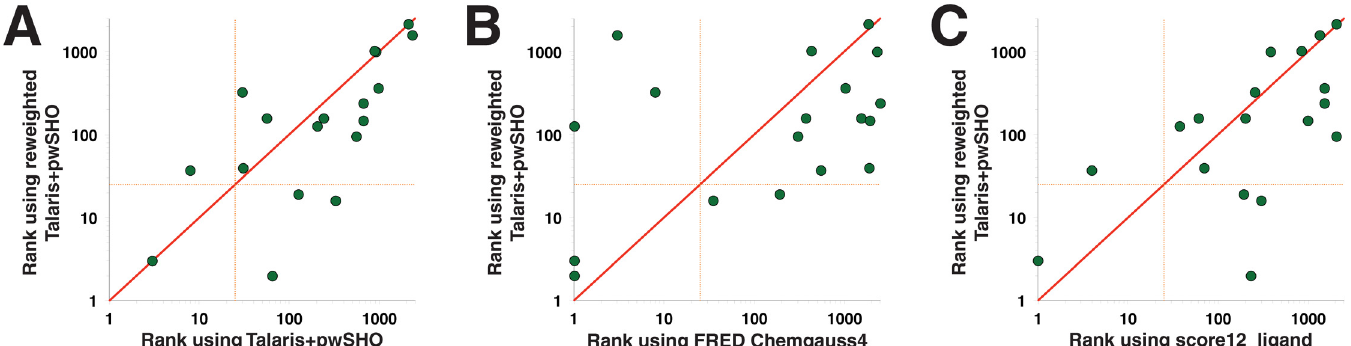
Fig 4. New weights for identifying small-molecule inhibitors of protein-protein interactions. Using the Talaris+pwSHO functional form of the energy function, we identified new weights to optimize Rosetta ’ s ability to distinguish true inhibitors from decoy compounds. The results presented here were obtained by leave-one-out cross validation of the weights over the benchmark set of 18 non-redundant protein targets. (A) Reweighting of the Talaris +pwSHO energy function leads to improved performance, though not at a statistically significant level (p = 0.078). (B) This new reweighted energy function provides comparable performance as FRED ’ s Chemgauss4 energy function (p = 0.221). (C) The new reweighted energy function slightly outperforms score12_ligand, though again not to a degree attaining statistical significance (p =